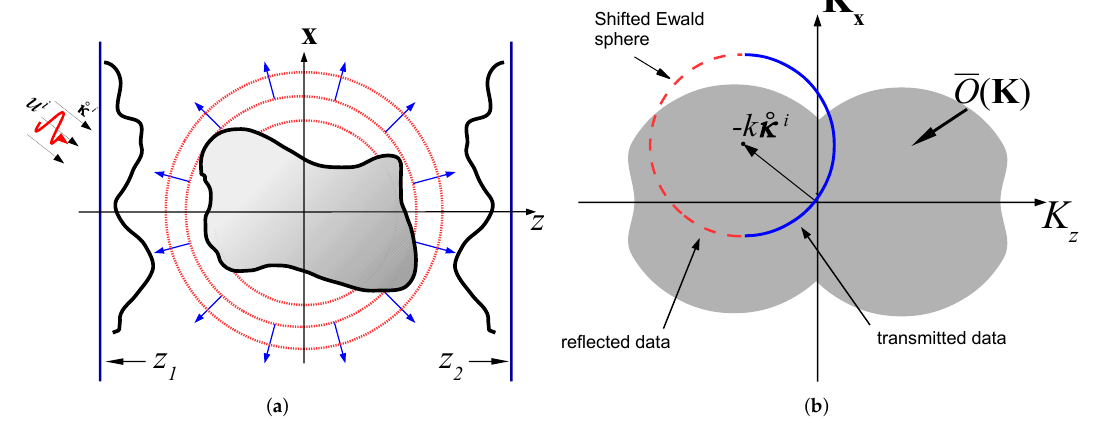
Figure 1. Diffraction tomography and the K -space diffraction tomography identity in the spatial and spectral domains. ( a ) The physical configuration. The unknown object O ( r ) is located between two measurement planes. At z = z we have an array of sources/receivers, while at z = z we have 1 2 an array of receivers. The object is illuminated by the plane-wave (black arrows) of Equation (3) propagating in the direction ◦ κ i . In red we plot pulsed plane-wave illumination of Equation (3). The scattered field is measured on the z j planes. ( b ) The DT identity of (8). The plane-wave ( ξ ) is mapped to values of ¯ O ( K ) over a shifted Ewald sphere spectrum of the scattered field ˆ˜ u s j K = k ( ◦ κ j − ◦ κ i ) . The data measured on the j = 1,2 planes are illustrated by red dashed and blue solid-line hemispheres,